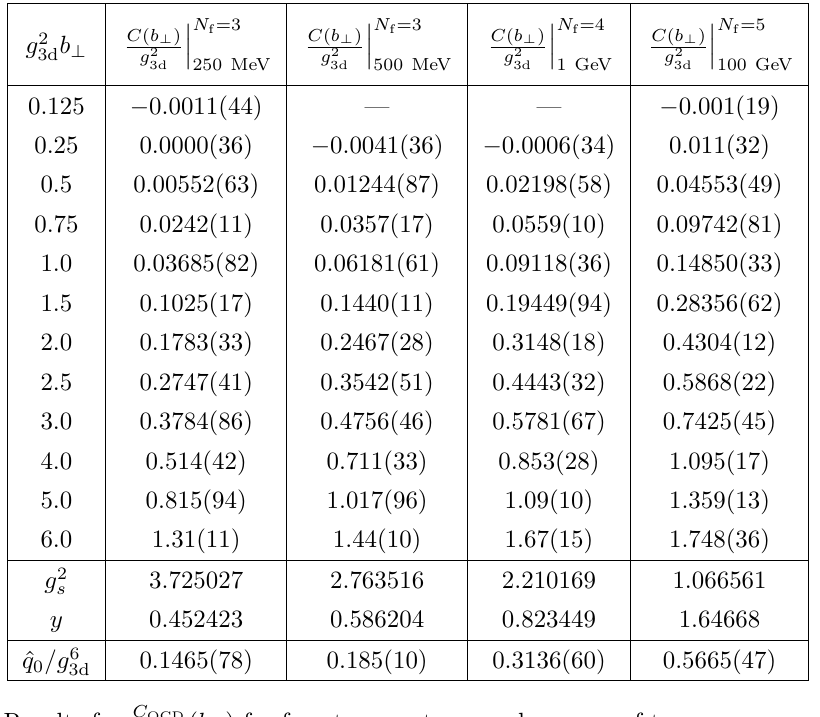
position space. Schematically, rewriting (2.1)